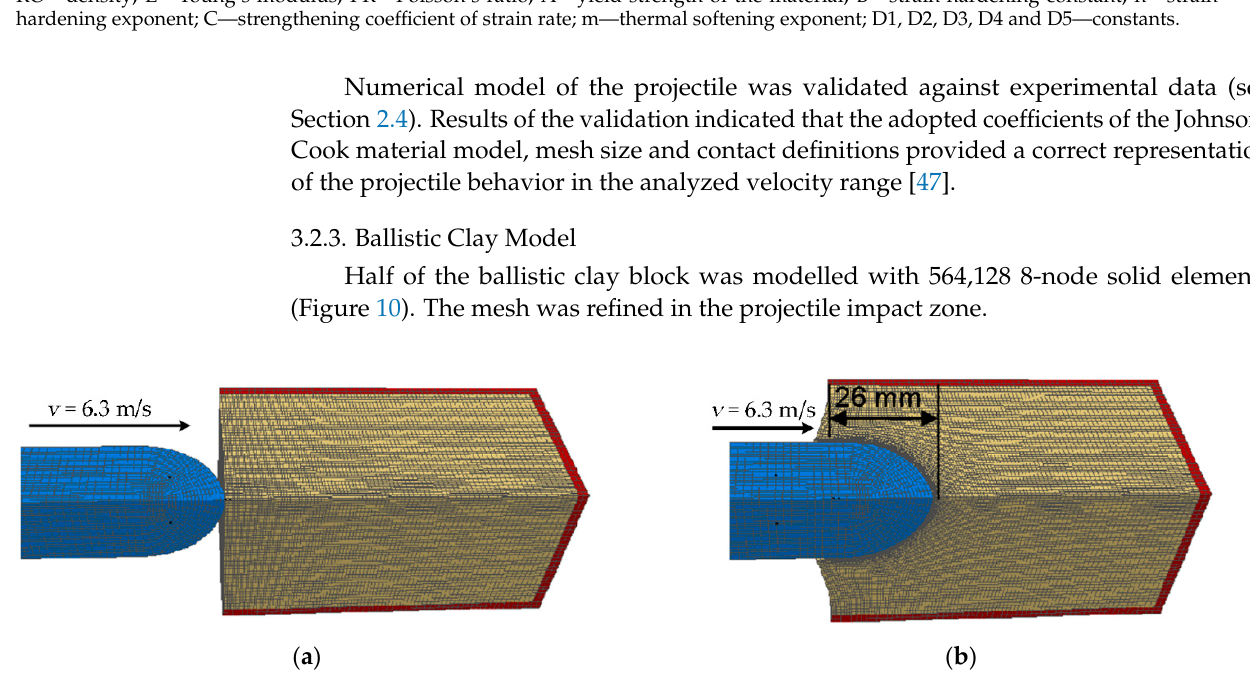
Figure 10. Ballistic clay validation: ( a ) Initial position and ( b ) impactor indentation in clay.